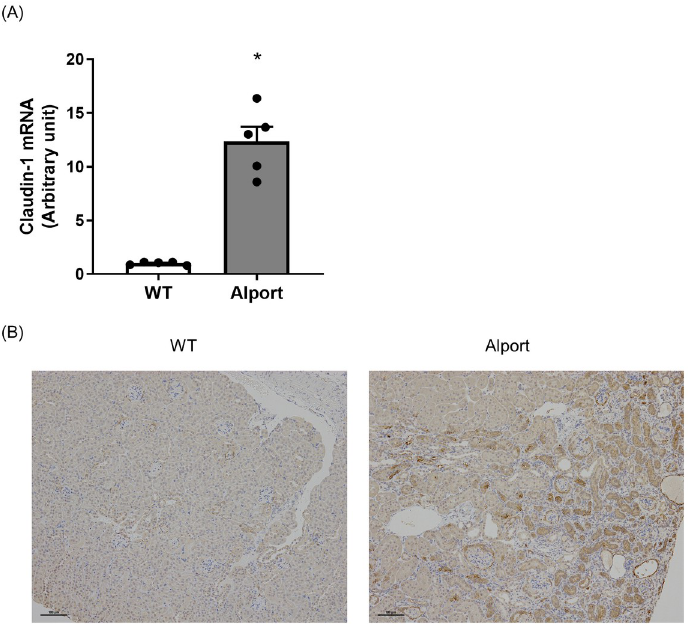
Fig 3. Increased CL-1 expression in Alport mice. In the kidney of Alport mice, CL-1 mRNA expression was significantly increased (A). Representative immunohistochemical images of CL-1 in the kidney. In Alport mice, CL-1 was strongly stained in proximal tubular cells. Scale bar indicates 100 μ m (B). Relative mRNA expression was calculated as the ratio to GAPDH expression. The actual values are represented as dots and the columns represent mean + SE. � p < 0.05, significant difference versus WT (Student’s t-test). WT: wild type mice, Alport: Alport mice.